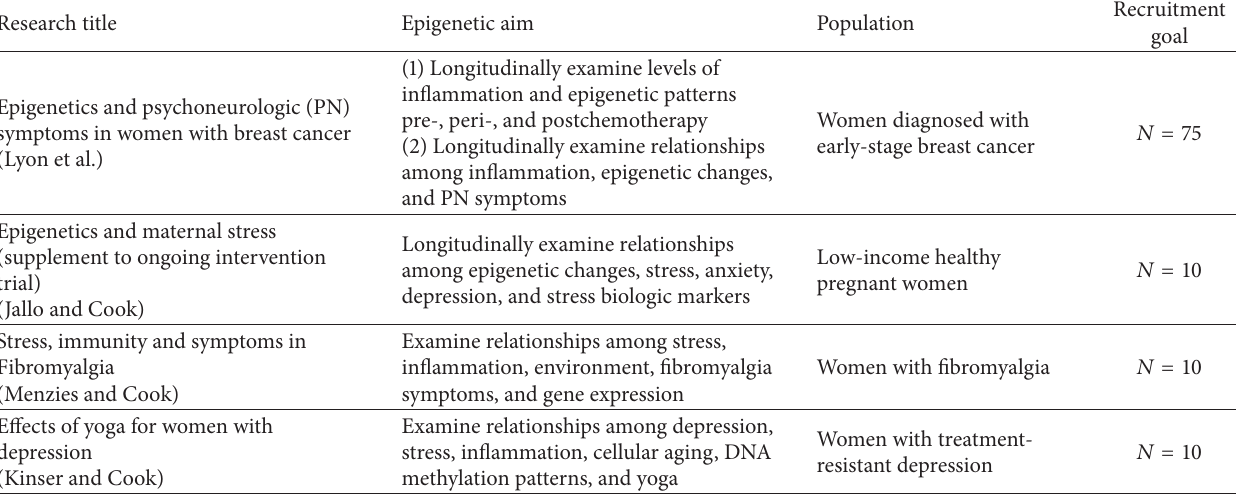
Table 1: Overview of studies.